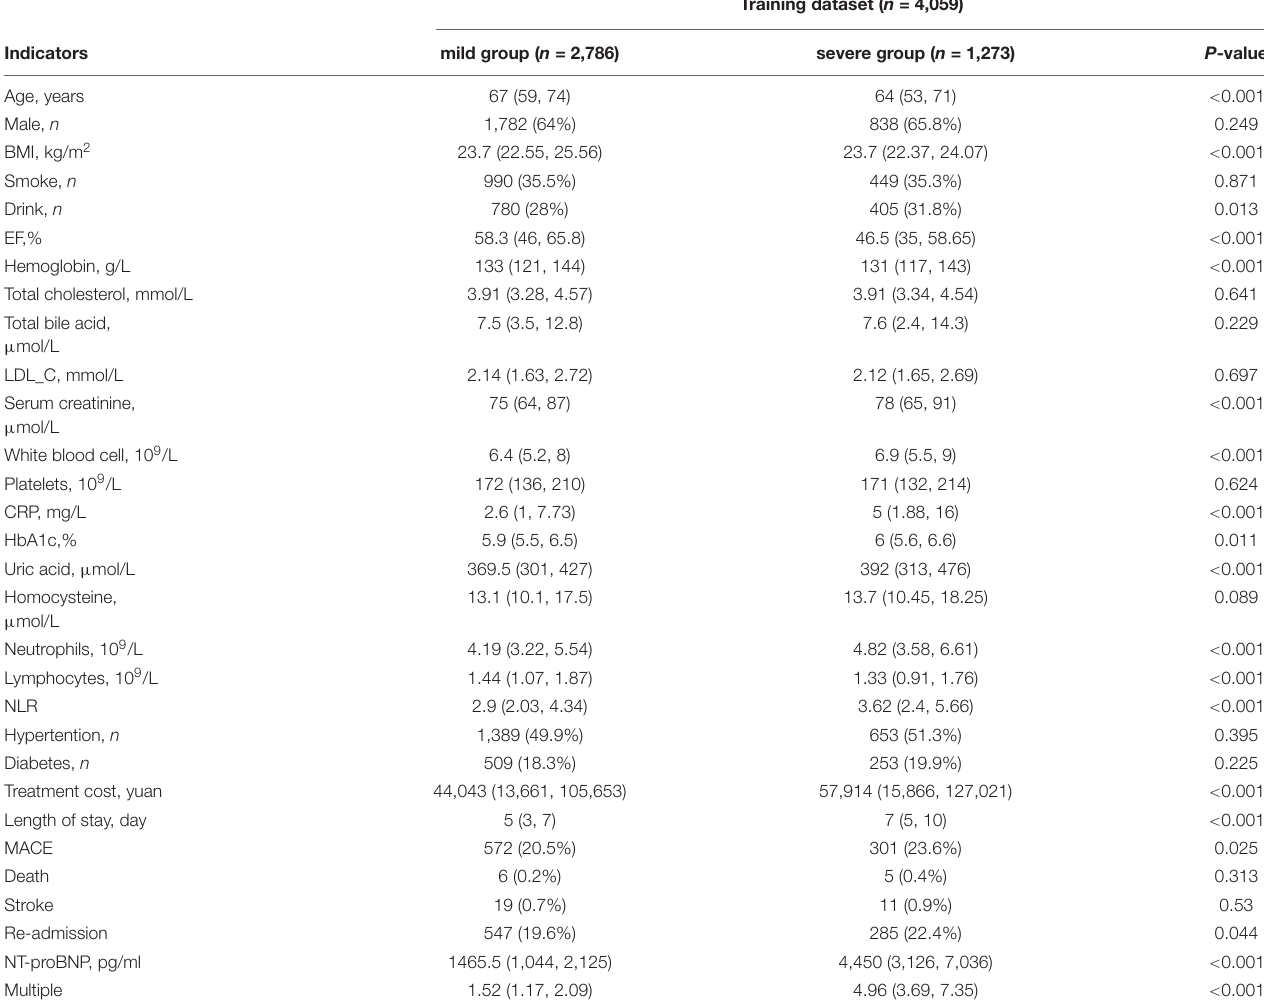
Training dataset ( n =